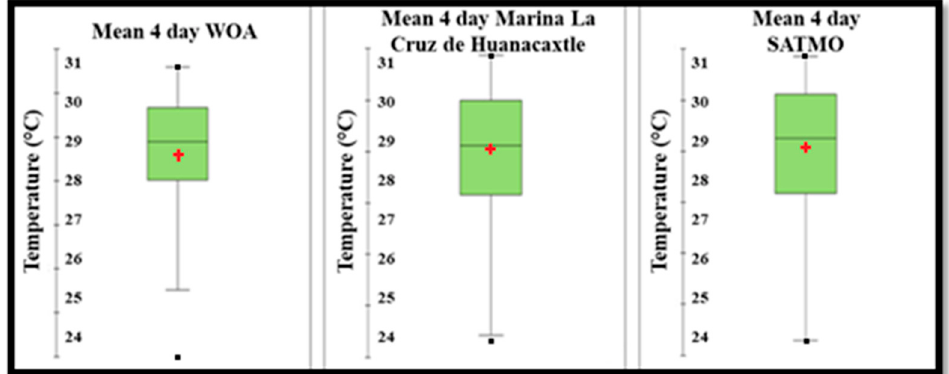
Figure 8. Comparison of the monthly average 4 days of in situ data from Marina La Cruz de Huanacaxtle, SATMO and WOA.